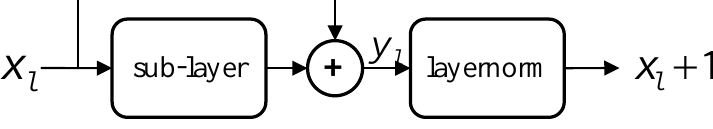
Figure 8. Post-norm residual unit.